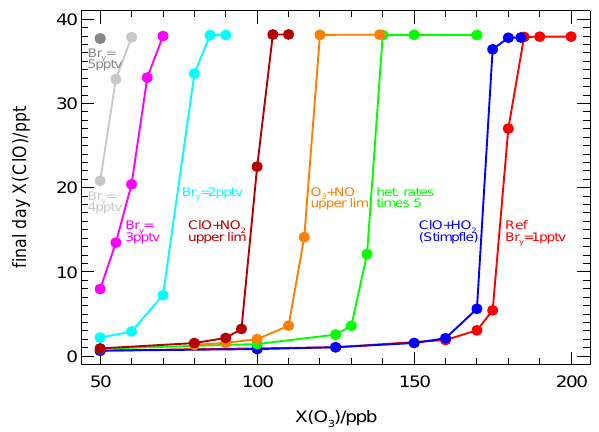
Fig. 11. Sensitivity of final day ClO in the CLaMS BT simulation results for the flight on 19 November 2005 (Fig. 8) to ozone mixing ratio for various input parameterisations as described in detail in the text. The changes made to the reference parameterisation (red) are indicated in the graph and are cumulative from right to